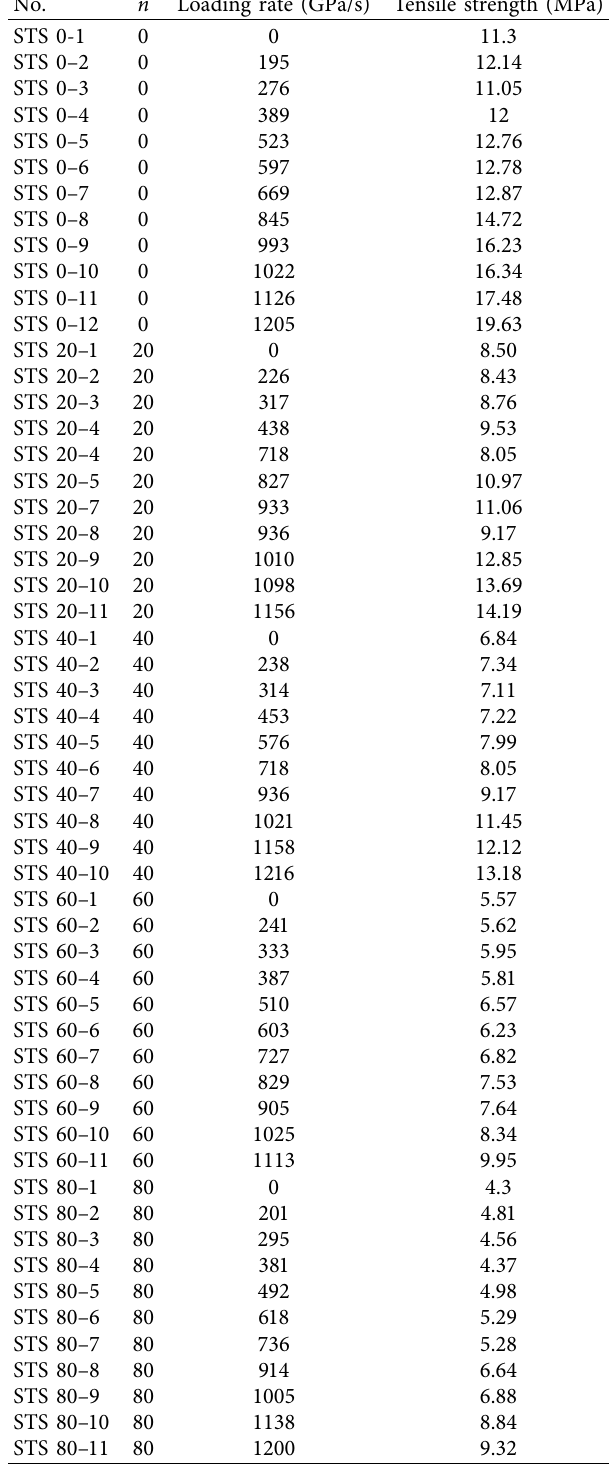
Table 1: Dynamic tensile test results of